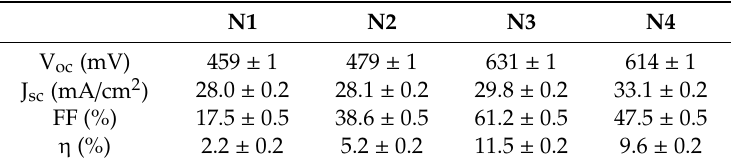
Table 2. The photovoltaic parameters (Open-circuit voltage V oc , short-circuit current density J sc , Fill factor FF, Photovoltaic conversion e ffi ciency η ) of the solar cells fabricated. N1, N2, N3 are the cells with V 2 O 5 layer thicknesses 25 nm, 35 nm, 50 nm respectively. N4 is the cell without the Ag:Al metallic layer with 50 nm thickness of V 2 O 5 layer. The increase in the V oc and FF of the cells could be observed as the thickness of the V 2 O 5 increases. A huge decrease in the FF is observed in N4 due to the high sheet resistance of the layers.